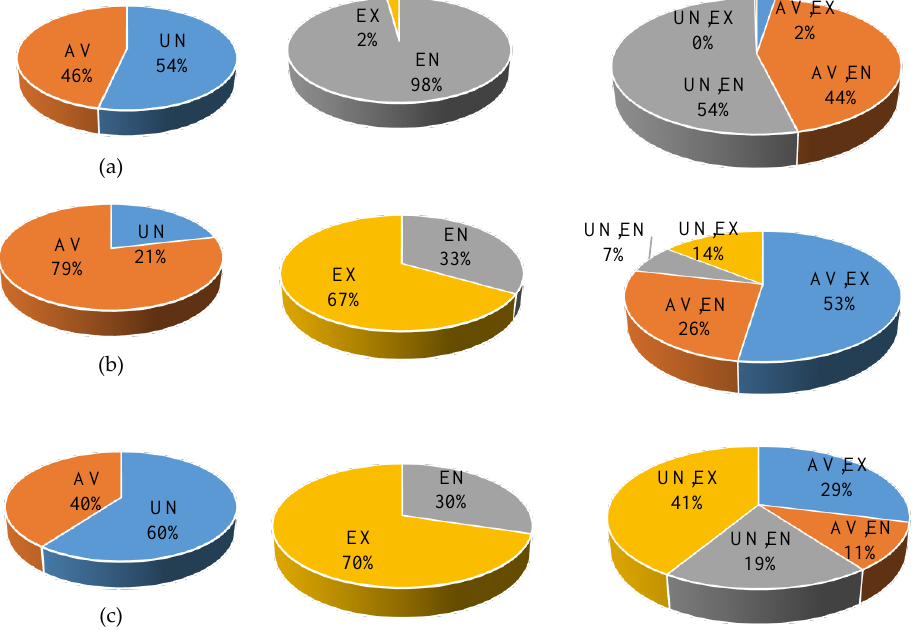
Figure 4. Splitting exergy destruction rates of components: ( a ) the evaporator, ( b ) turbine and ( c ) condenser in the BORC system.